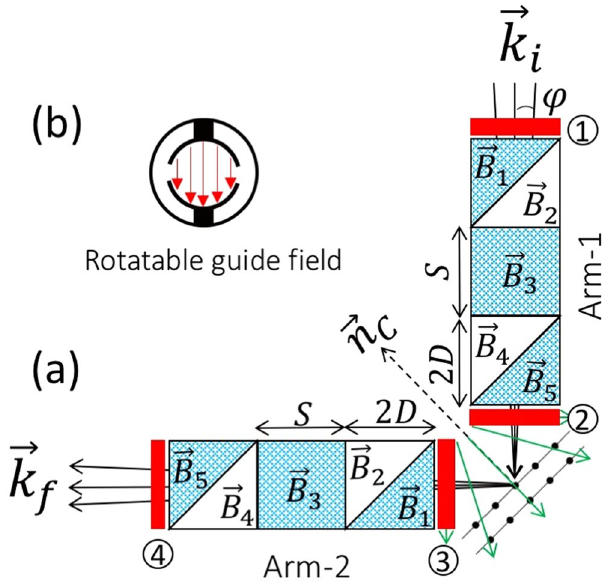
Figure 5. ( a ) Schematic of the double-arm Larmor diffraction. Regions with different colours refer to different magnetic field directions, where blue refers to the main field inside the device, green arrows refer to the guide field (shown in ( b )) between the two arms and red refers to the rotatable guide field on the two ends of the device. Please note that the arm in Fig. 1(b) now goes after the sample and this causes the sense of the triangles in the arm before the sample is different from Fig. 1(b), which means the calculation of the effective tilting angle for this arm using Eq. 8 will take the opposite sign.